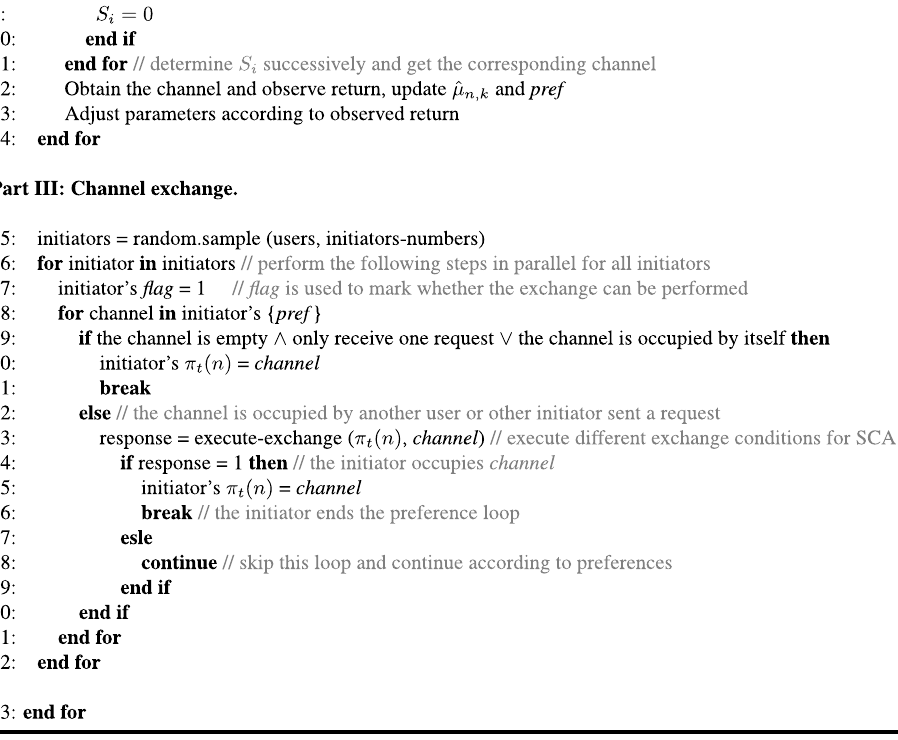
Figure 12. The PPL-LC